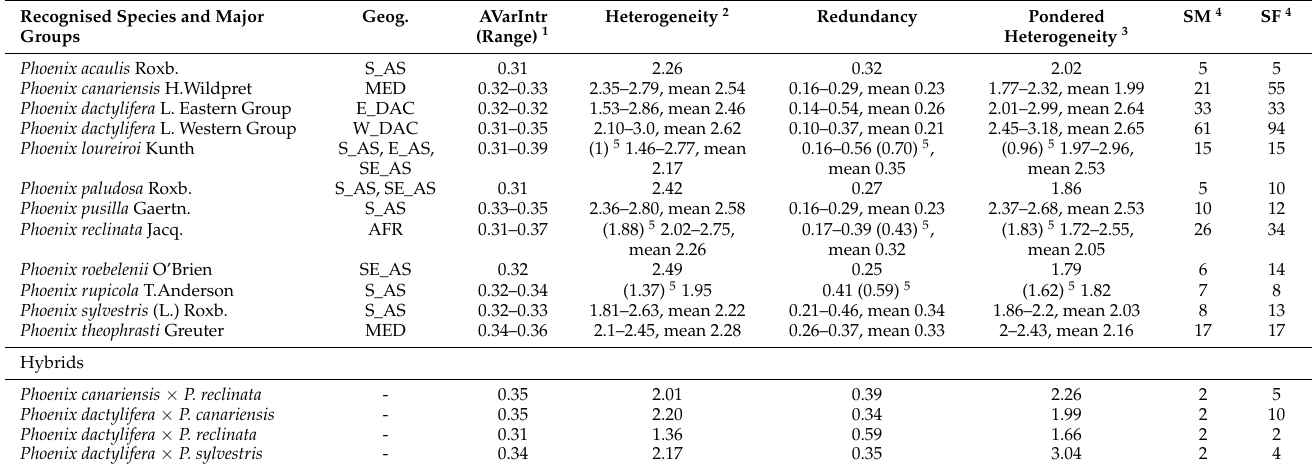
Table 5. Species and hybrids intraindividual/intrapopulational variability, heterogeneity and